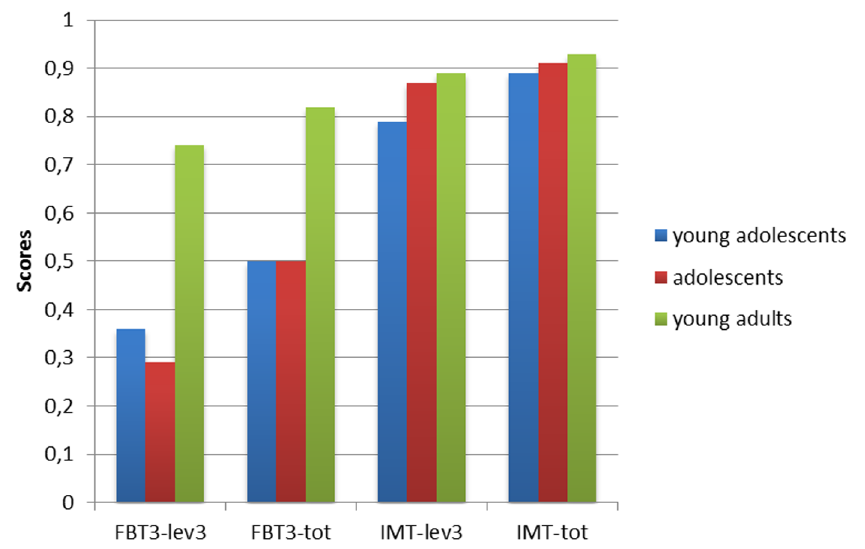
Figure 1. Age effect on third levels and total scores of Imposing Memory Task and False-Belief Task.